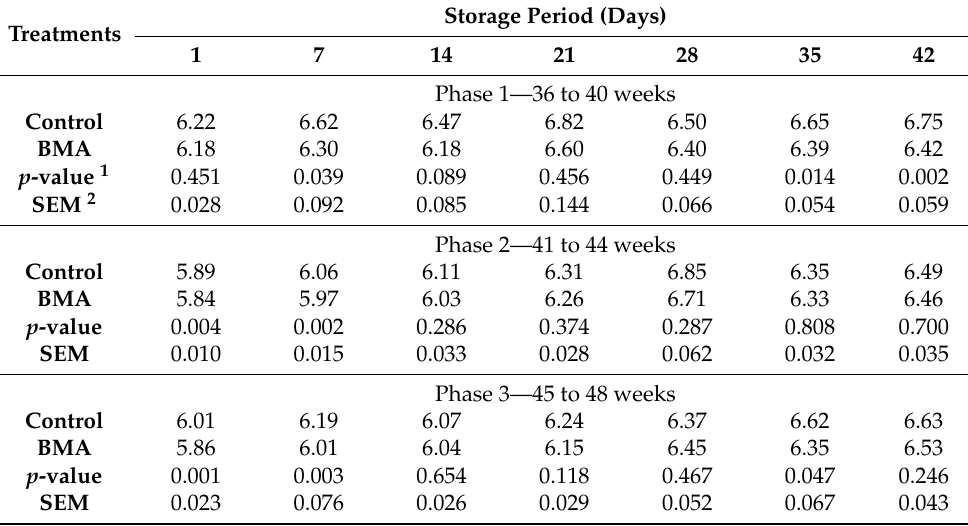
Table 3. Yolk pH of eggs from laying hens fed with β -mannanase depending on storage time.